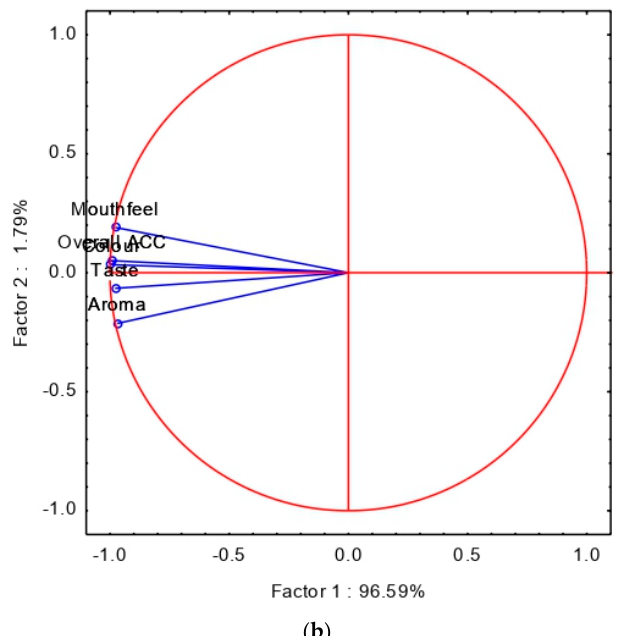
Figure 2. Principal component analysis (PCA) of amahewu samples (Overall ACC means